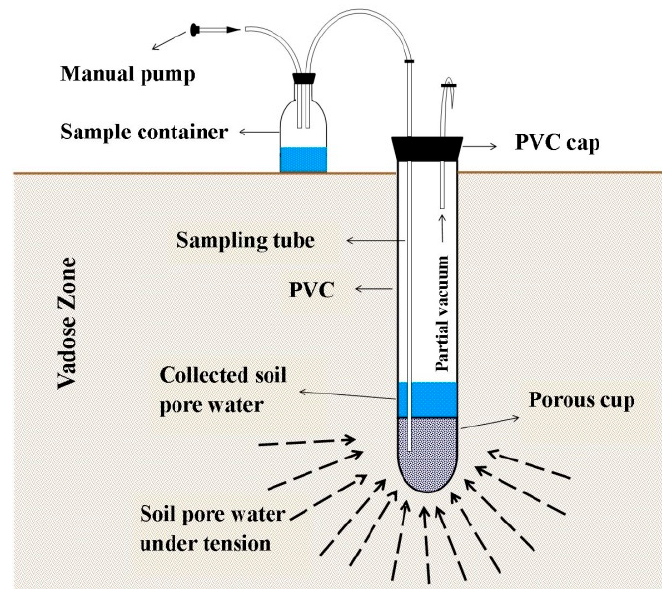
Figure 2. Components of suction cup lysimeter.